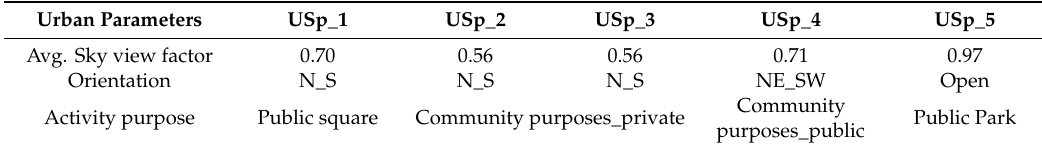
Table 1. Characteristics of principle urban spaces.